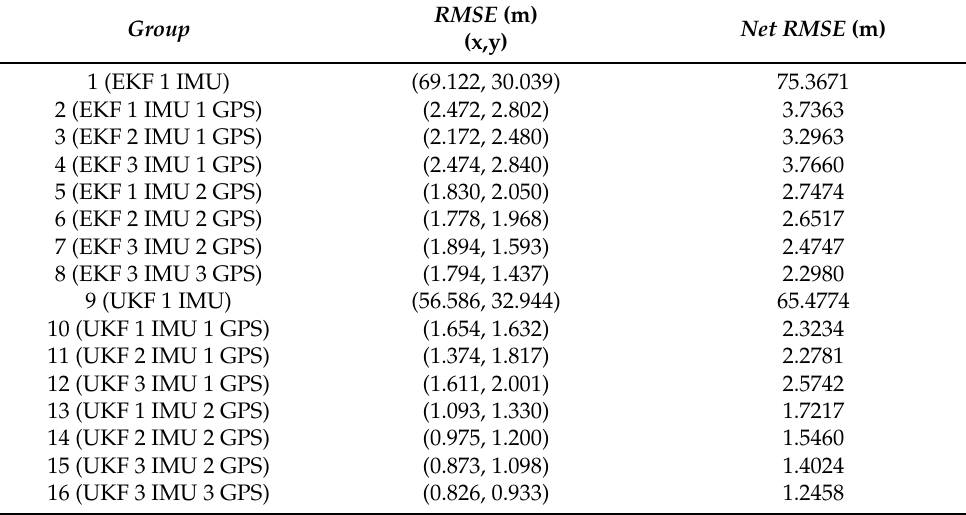
Table 2. Localization errors of each